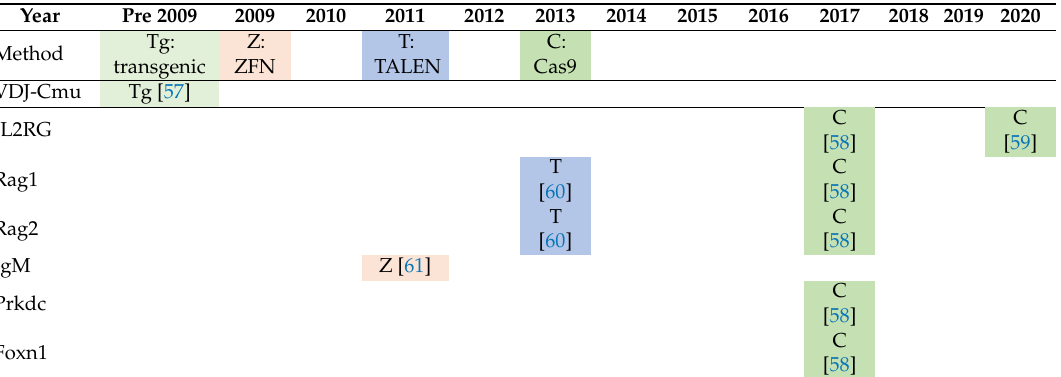
Table 2. Production of immunodeficient rabbits. The “Method” row indicates the debut year of the method. Tg: transgenic, refers to the conventional method used in transgenic animal production, without the use of gene editing nucleases or any other gene targeting